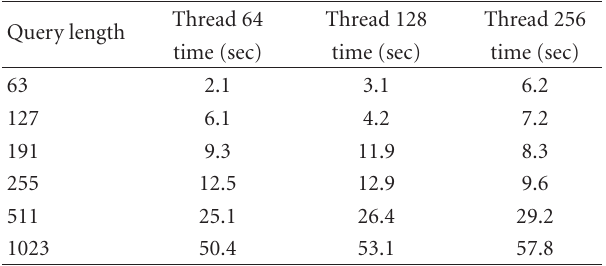
Table 2: Performance comparison for di ff erent numbers of threads per block (64, 128, 256). All query sequences run against the SWISS- PROT database